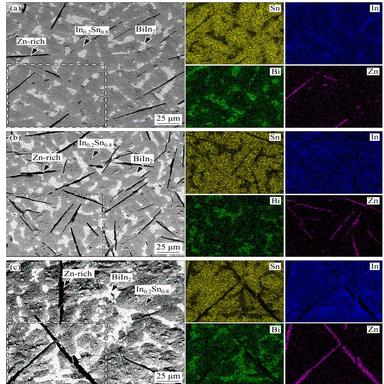
EM−BSE images and corresponding EDS mapping of (Sn1−xZnx)57(In0.78Bi0.22)43 solder alloys: (a) x=0.10; (b) x=0.15; (c) x=0.20